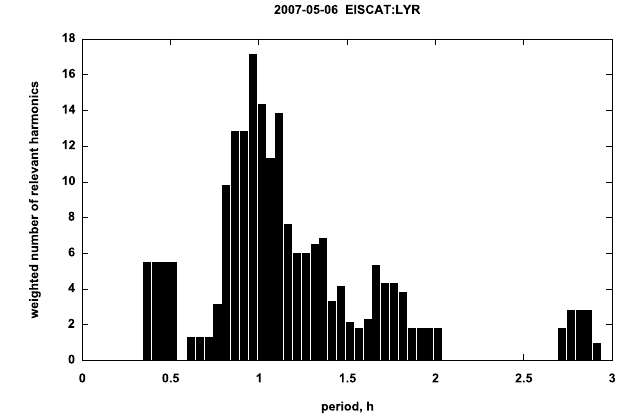
Fig. 5. Lomb-Scargle periodogram of the field-aligned ion veloc- ity at the altitude 228.5km on 6 May 2007 and the 50% statistical significance level (horizontal dashed line).